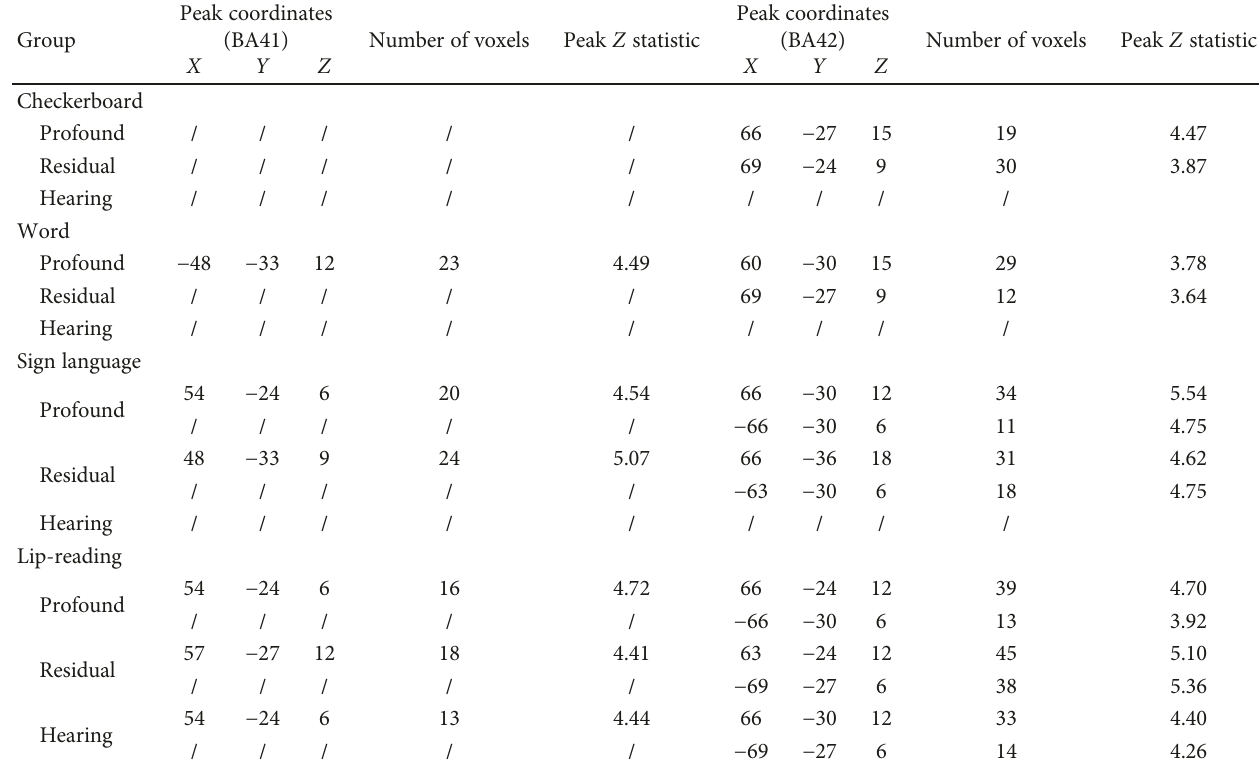
Table 2: Peak activations for BA41 and BA42: profoundly deaf, residual hearing, and hearing groups ( p < 0 001 , uncorrected, minimum cluster size